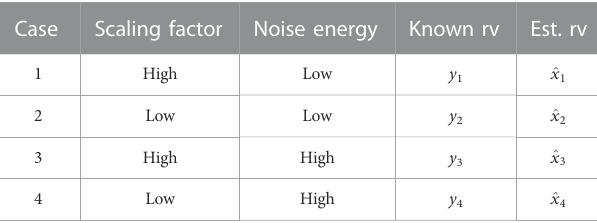
TABLE 3 Proposed cases for the performance analysis. Scaling